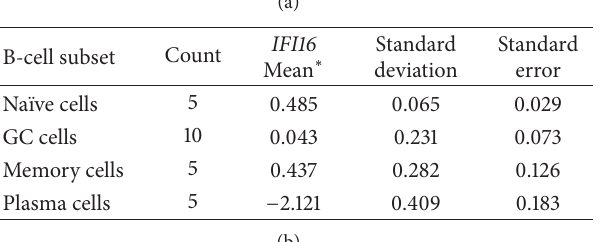
Table 1: IFI16 gene expression analysis in normal B-cell